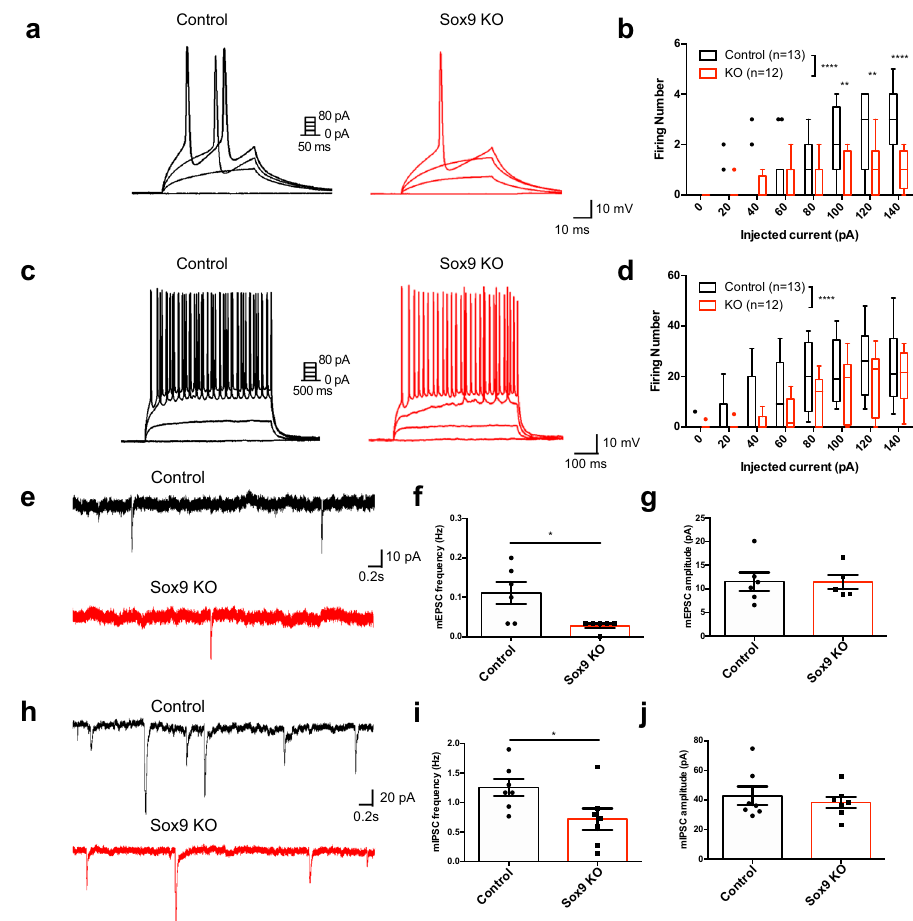
Fig. 4 Electrophysiological recordings showed a reduction in evoked APs in M/T as well as altered synaptic properties. ( a – d ) Whole-cell patch clamp electrophysiology of M/T cells revealed a reduction in fi ring number from stepped current injections with Sox9 KO in astrocytes vs control astrocytes. n = 13 cells (control) and n = 12 cells ( Sox9 KO) from N = 3 mice, respectively. ** p = 0.0023 and 0.0014 for 100 and 120 pA current injections, respectively; **** p < 0.0001; Two-way ANOVA with Sidak ’ s multiple comparison correction. Data are presented as box plots displaying interquartile range and median with Tukey whiskers. e Example traces of mEPSC recordings in M/T cells with control astrocytes (top) and Sox9 KO astrocytes (bottom). f M/ T cells with Sox9 KO astrocytes show a signi fi cant decrease in mEPSC frequency compared to control astrocytes. n = 8 cells (control) and n = 7 cells ( Sox9 KO) from N = 3 mice, respectively. * p = 0.0156. Two-tailed Student ’ s t-test. Data are presented as mean values ± SEM. g M/T cells show no changes in mEPSC amplitude with Sox9 KO in astrocytes. n = 8 cells (control) and n = 7 cells ( Sox9 KO) from N = 3 mice, respectively. Two-tailed Student ’ s t-test. h Example traces of mIPSC recordings in M/T cells with control astrocytes (top) and Sox9 KO astrocytes (bottom). Data are presented as mean values ± SEM. i M/T cells with Sox9 KO astrocytes show a signi fi cant decrease in mIPSC frequency compared to control astrocytes. n = 7 cells (control) and n = 7 cells ( Sox9 KO) from N = 3 mice, respectively. * p = 0.0392. Two-tailed Student ’ s t-test. Data are presented as mean values ± SEM. j M/T cells show no changes in mIPSC amplitude with Sox9 KO in astrocytes. n = 7 cells (control) and n = 7 cells ( Sox9 KO) from N = 3 mice, respectively. Two-tailed Student ’ s t-test. Control is C57BL/6 J injected with AAV-GFAP-iCre-P2a-TurboRFP. Data are presented as mean values ±